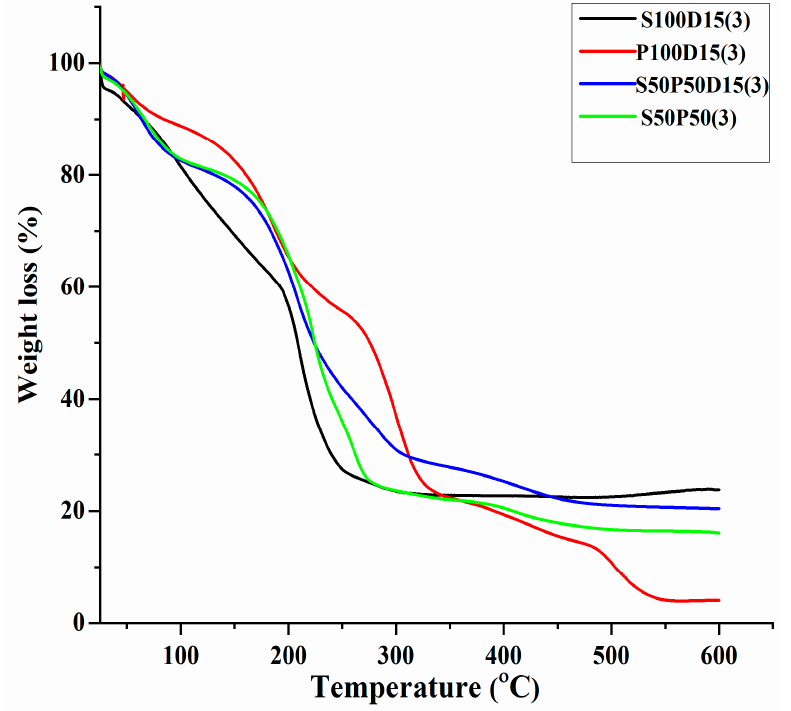
Figure 1. TGA thermograms of drug loaded (and unloaded) SA/PVA-MMT clay reinforced nanocomposite films. Table 2. Percentage of mass loss in drug loaded (and unloaded) SA/PVA-MMT clay reinforced nanocomposite films at different temperatures.